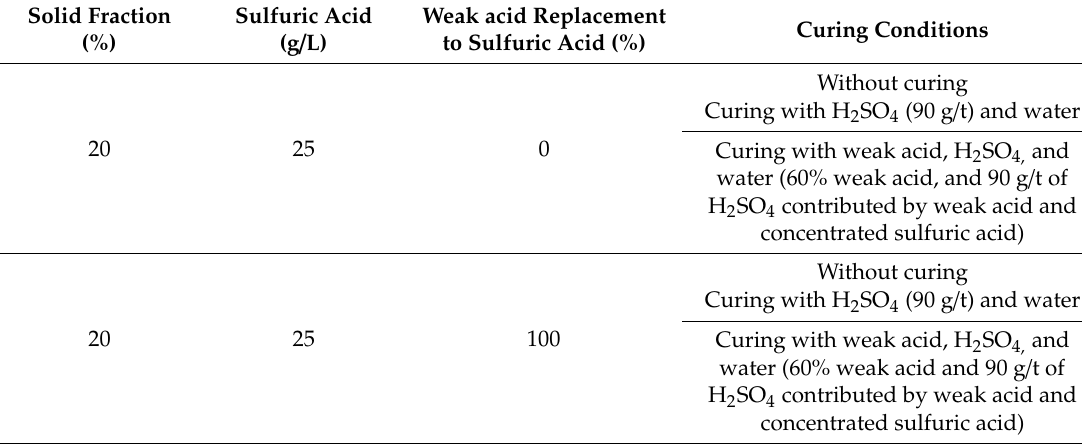
Table 5. Experimental design from the leaching